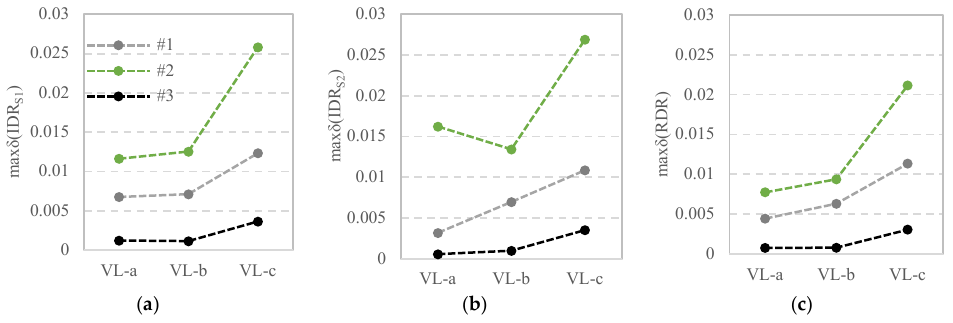
Figure 22. Maximum distance δ between the EDPs obtained with and without the vertical component for VL-a, VL-b, and VL-c. On the left ( a ), the max δ obtained from IDRs 1 , in the centre ( b ), the max δ obtained from IDRs 2 and on the right ( c ), the max δ obtained from the RDR. Table 7. Maximum values of the geometrical distance between the EDPs calculated over each time history with and without the vertical component.